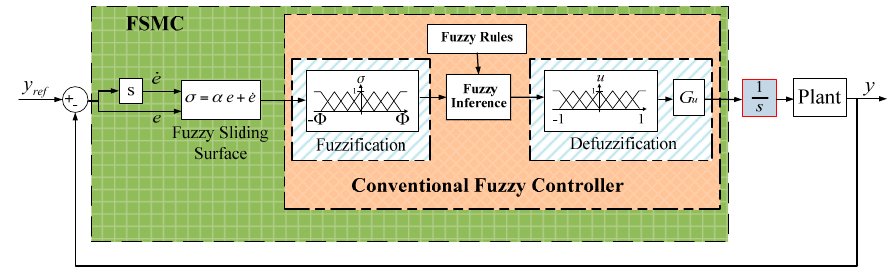
Figure 9. Block diagram of MFSMC system.